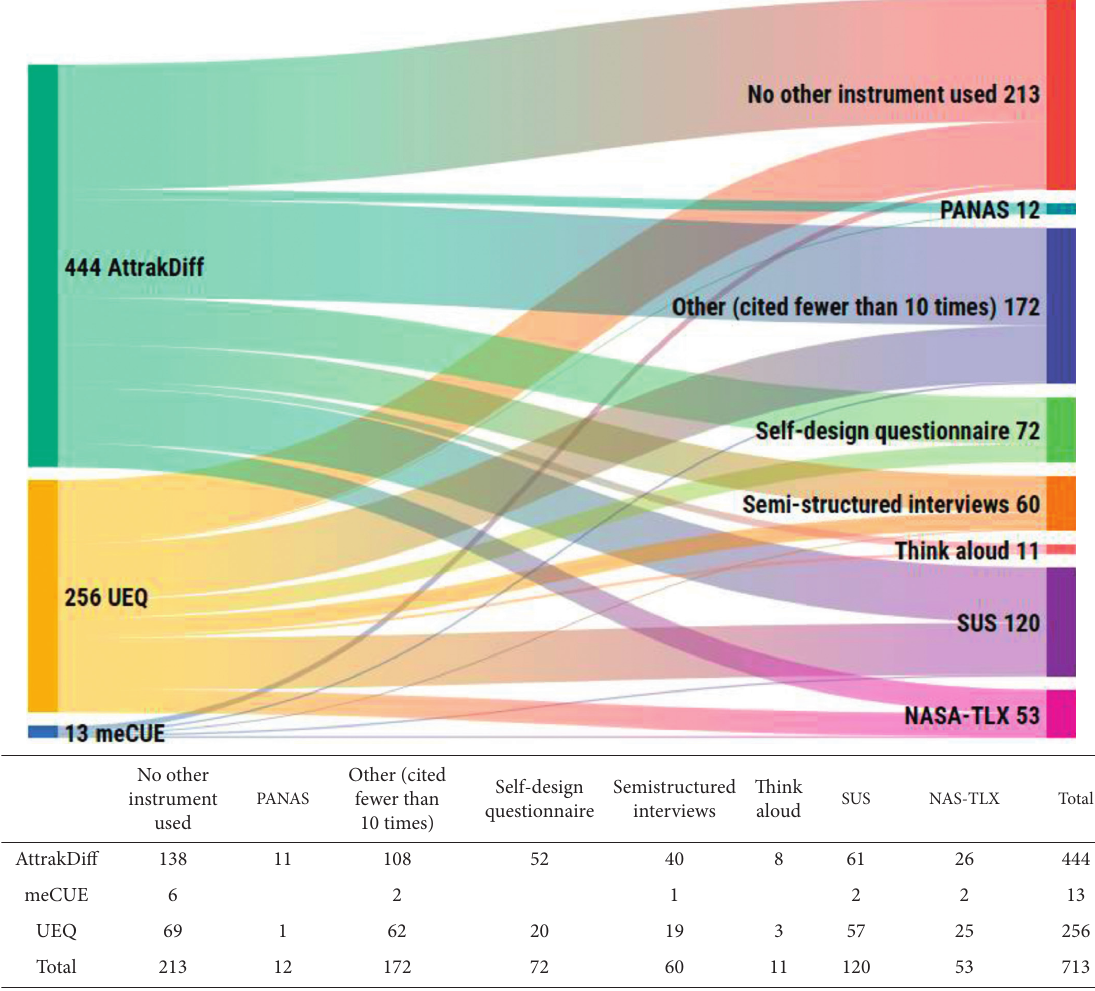
Figure 9: Additional instruments used in combination with the three standardized Table 6: Percentage of standardized questionnaires for all studies and for studies with topics related to ubiquitous computing and ambient intelligence.